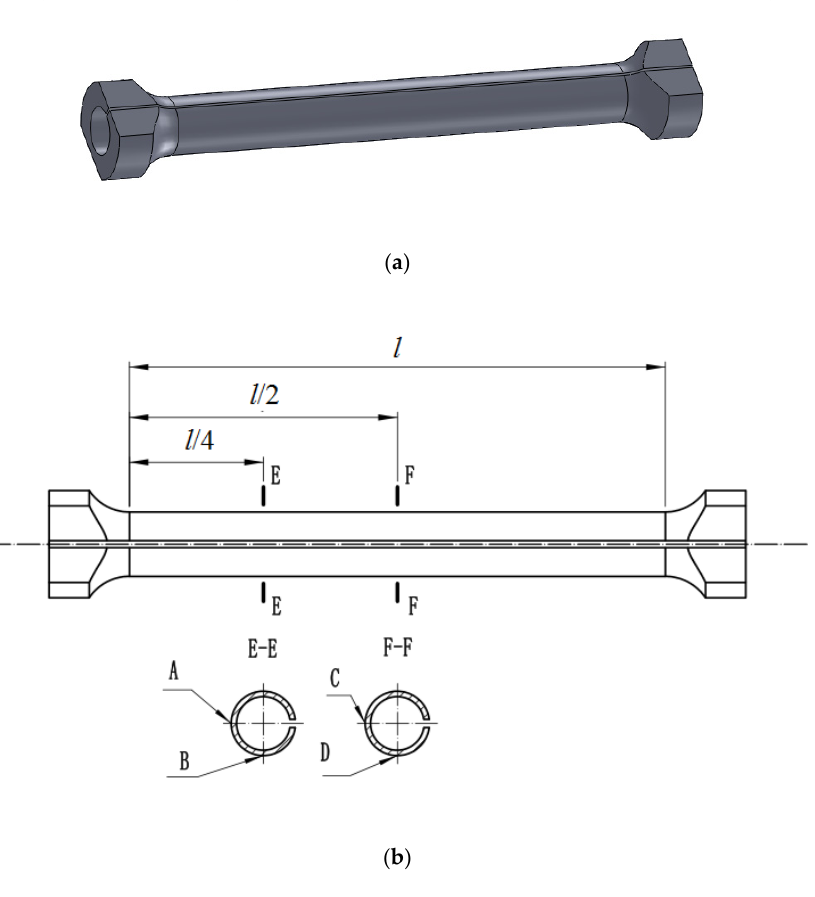
Figure 7. Torsion bar with an open annular section. ( a ) The 3D model of the torsion bar with an open annular section. ( b ) The exact measurement points of A, B, C, and D.